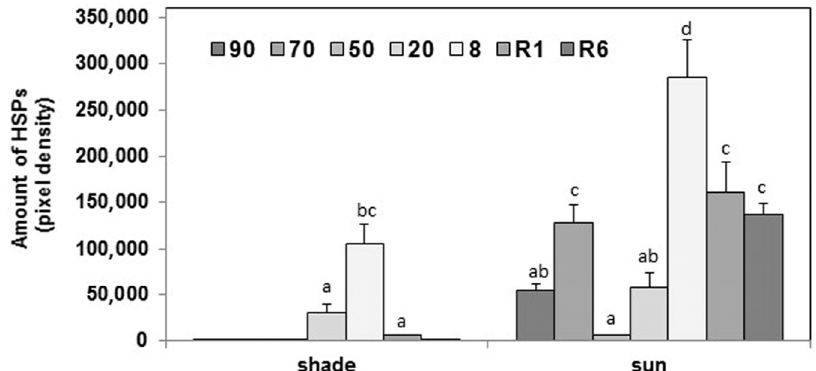
Figure 5. Changes in the relative amounts of total sHSPs in leaves of shade and sun H. rhodopensis plants during dehydration and rehydration. The relative amounts of the sHSP bands were determined based on Western blotting and normalized to the same total stained protein values in the lanes. Values are given as mean ± SD ( n = 3). Changes between shade and sun plants were statistically compared. Different letters within a graph indicate significant differences assessed by the Fisher LSD test ( p ≤ 0.05) after performing multifactor ANOVA.